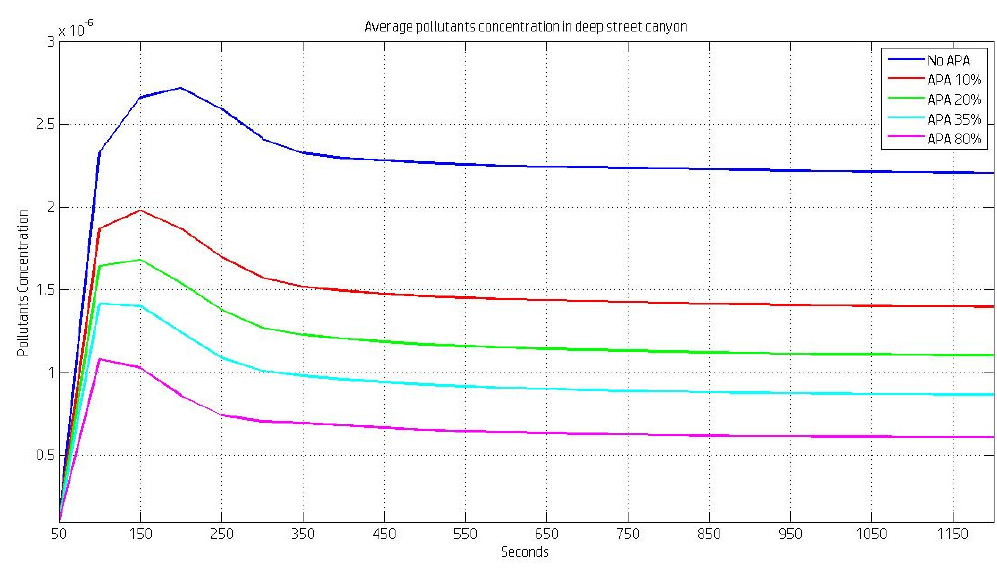
Figure 16. Average passive tracer concentration in a deep street canyon with aspect ratio H/W = 3, simulated in the presence of a constant emission from the street floor. Different APA abatement efficiencies are analyzed.